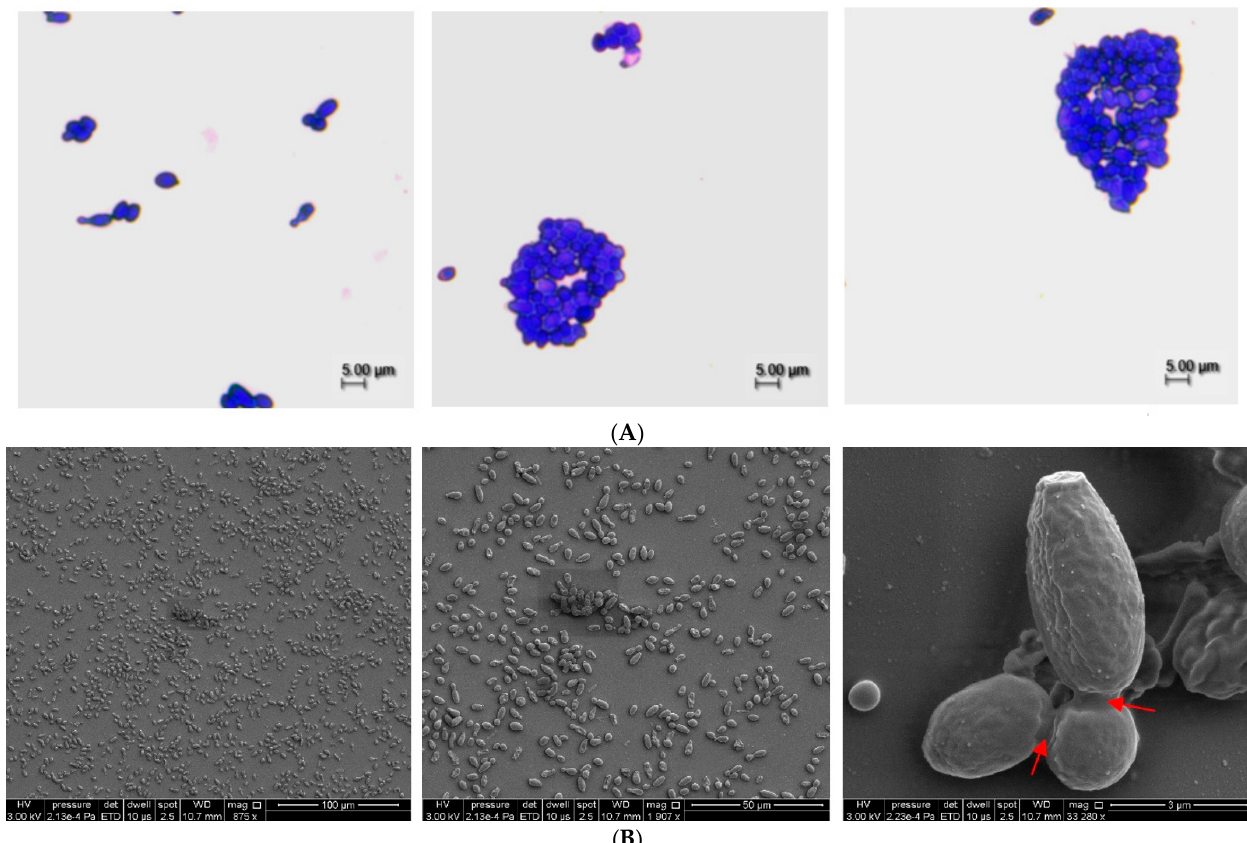
Figure 4. Light microscopic and SEM observations of S. boulardii CNCM I-745 biofilms formed on the glass surface in the beer model after 72 h of storage at 20 °C. ( A ) Light microscopic micrographs (magnification: ×400, scale bar 5 μ m) depicting attached single cells and developed microcolonies on the glass surface. ( B ) SEM micrographs displaying the biofilm structure and amorphous extracellular matrix between cells (arrows).